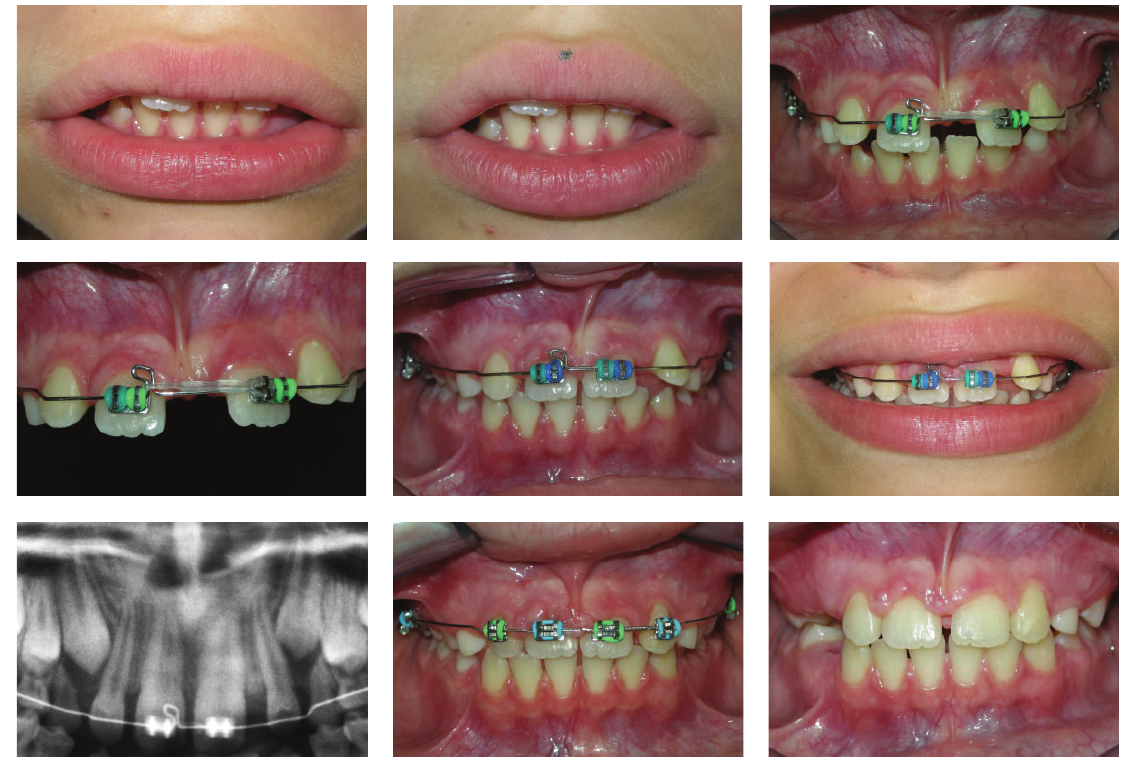
Figure 3: Progress. Determination of the correct midline and biomechanics for moving the maxillary right central incisor to the left. bands on the first permanent molars to move the left central incisor using the teeth on the right side or the archwire as an anchorage point. This latter approach was